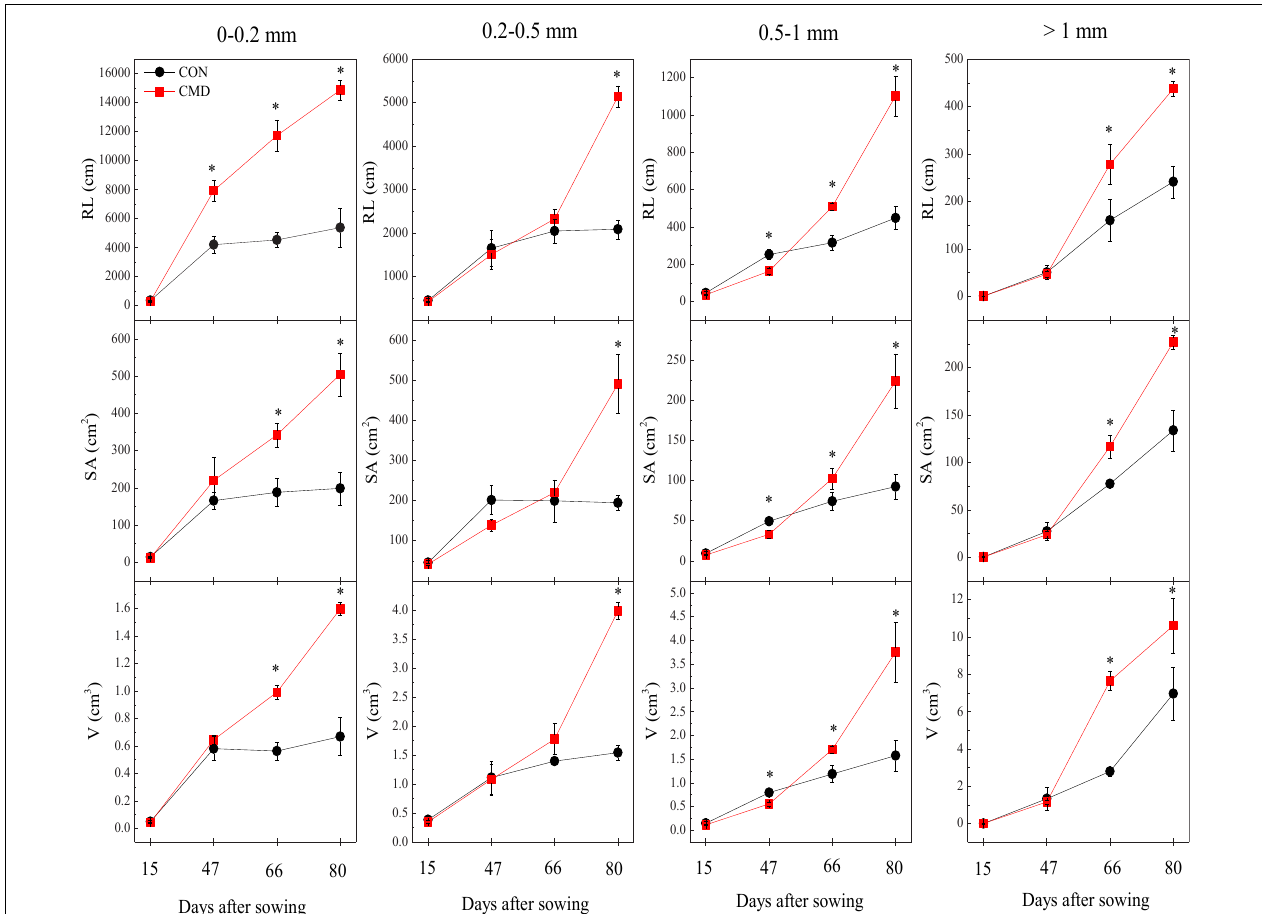
FIGURE 1 | Root length (RL), surface area (SA), and volume (V) at < 0.2, 0.2–0.5, 0.5–1, and > 1 mm root diameter of oat in CON and CMD treatments, at various growth stages. 15 days after sowing corresponds to the plant trefoil stage; 47 days after sowing corresponds to the plant elongation stage; 66 days after sowing corresponds to the plant pustulation stage; 80 days after sowing corresponds to the plant maturity stage. CON, control; CMD, cattle manure deposition. Data represents mean ± SE ( n = 3). The data was based on a pot experiment in one year. All parameters were analyzed with SPSS version 16.0 (SPSS Inc. Chicago, IL, United States). Differences in each root trait whining different diameter classes between CON and CMD treatments at various growth stages are indicated (*represents P <